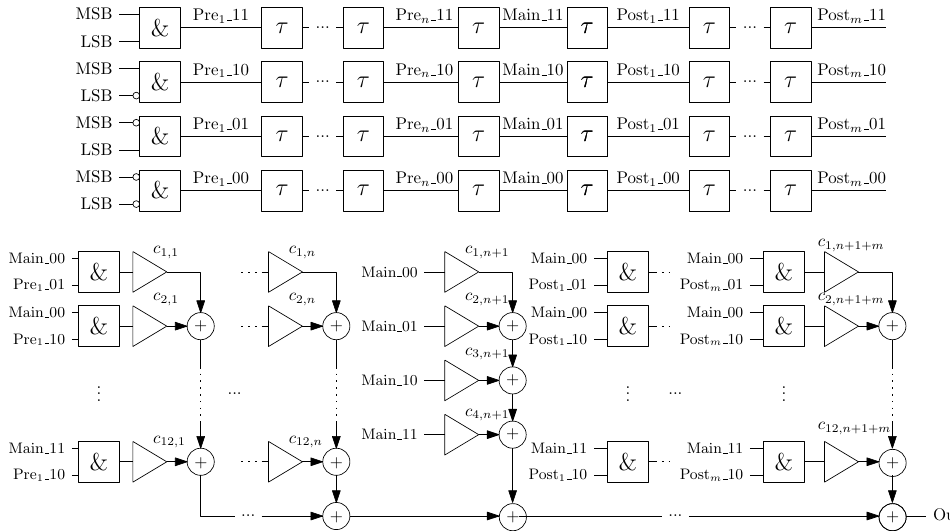
Figure 7. Block diagram of adaptive FFE, n pre and m post-taps, 12 sets of coefficients for PAM- 4